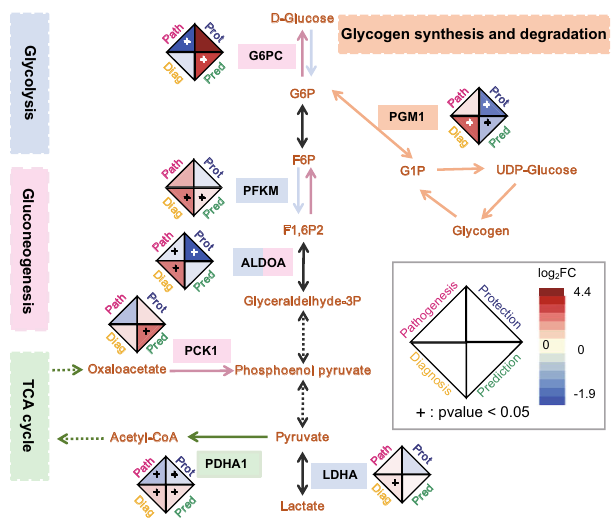
Fig. 4 Changes in proteins involved in carbohydrate metabolism in AMS. The log 2 FC of proteins in glycolysis (light purple background and arrows), gluconeogenesis (light pink background and arrows), the TCA cycle (light green background and arrows), and glycogen synthesis and degradation (light orange background and arrows) in the following four comparison groups are shown in the diamond shape: pathogenesis (path, pink background, AMS4k: n = 30, AMS1k: n = 30), protection (prot, dark blue background, nAMS4k: n = 23, nAMS1k: n = 23), prediction (pred, dark green background, AMS1k: n = 30, nAMS1k: n = 23), and diagnosis (diag, yellow background, AMS4k: n = 30, nAMS4k: n = 23). Carbohydrate metabolism was dysregulated in individuals after ascension to high altitude. The statistical methods were used paired/unpaired t test or Welch ’ s t test. TCA tricarboxylic acid